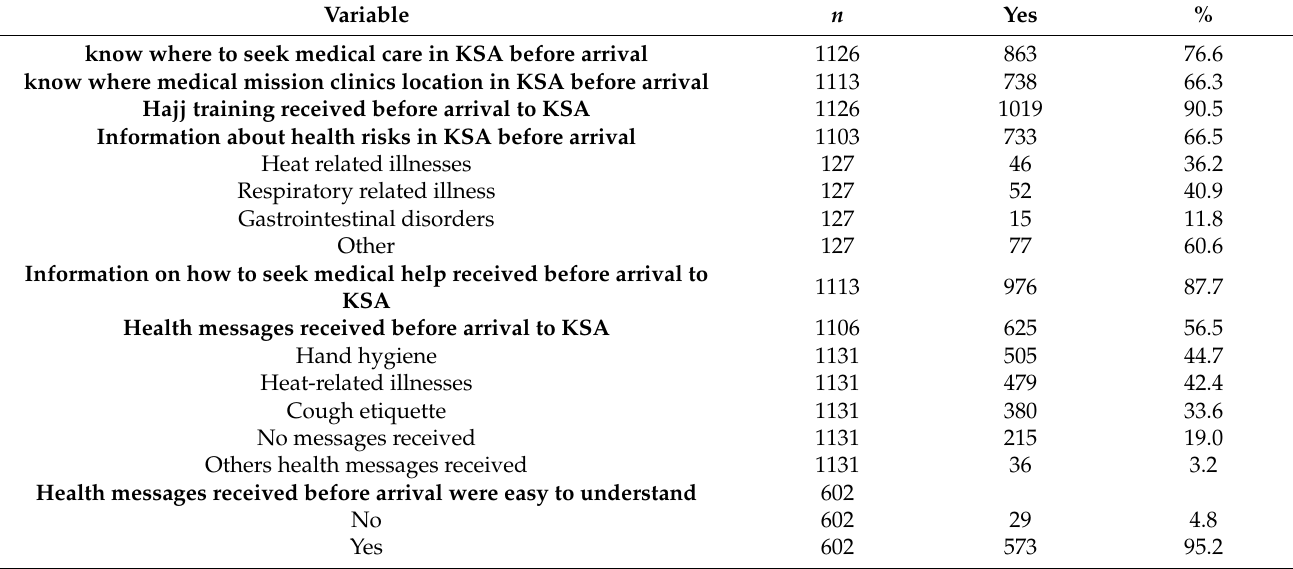
Table 3. Training and health promotion before arrival to KSA